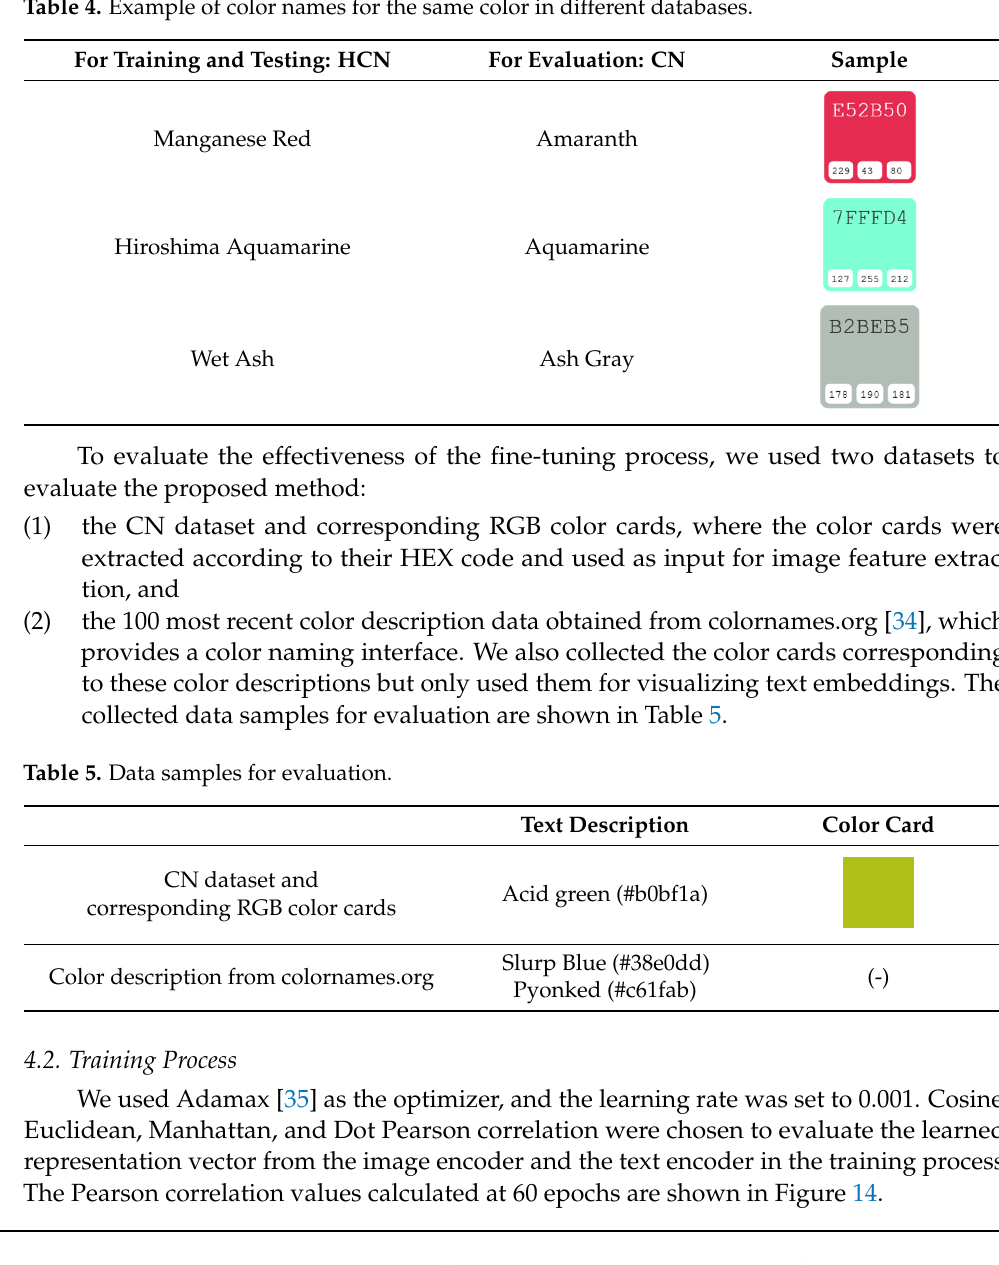
Table 3. Vocabulary differences between CN and HCN.